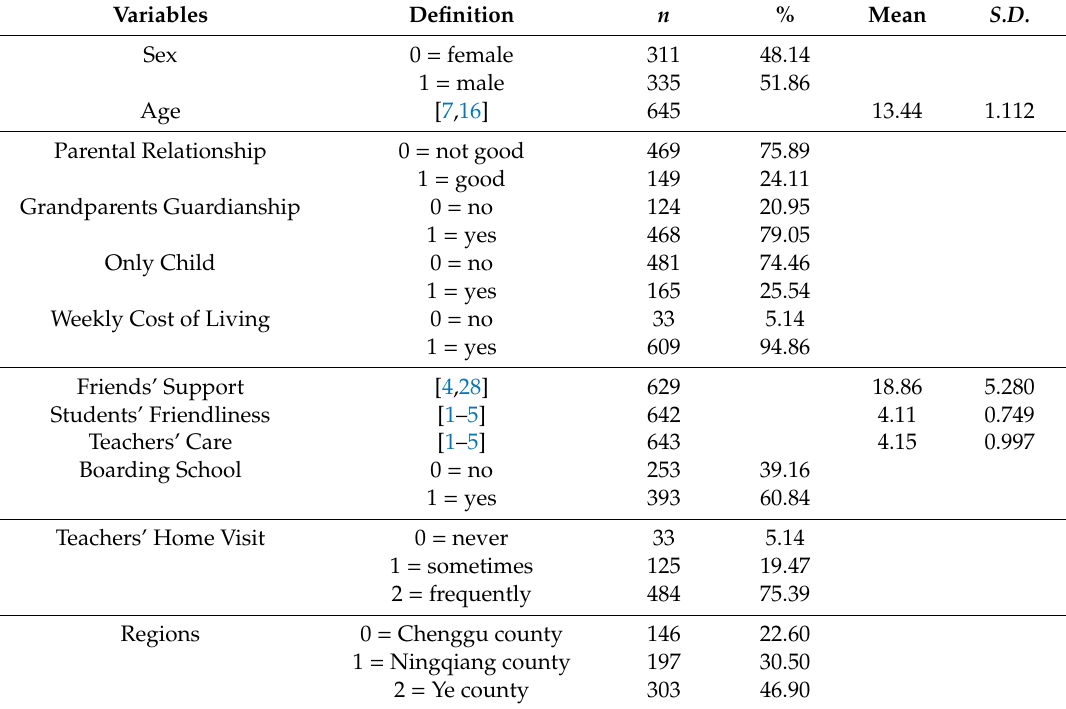
Table 4. Characteristics of controlled